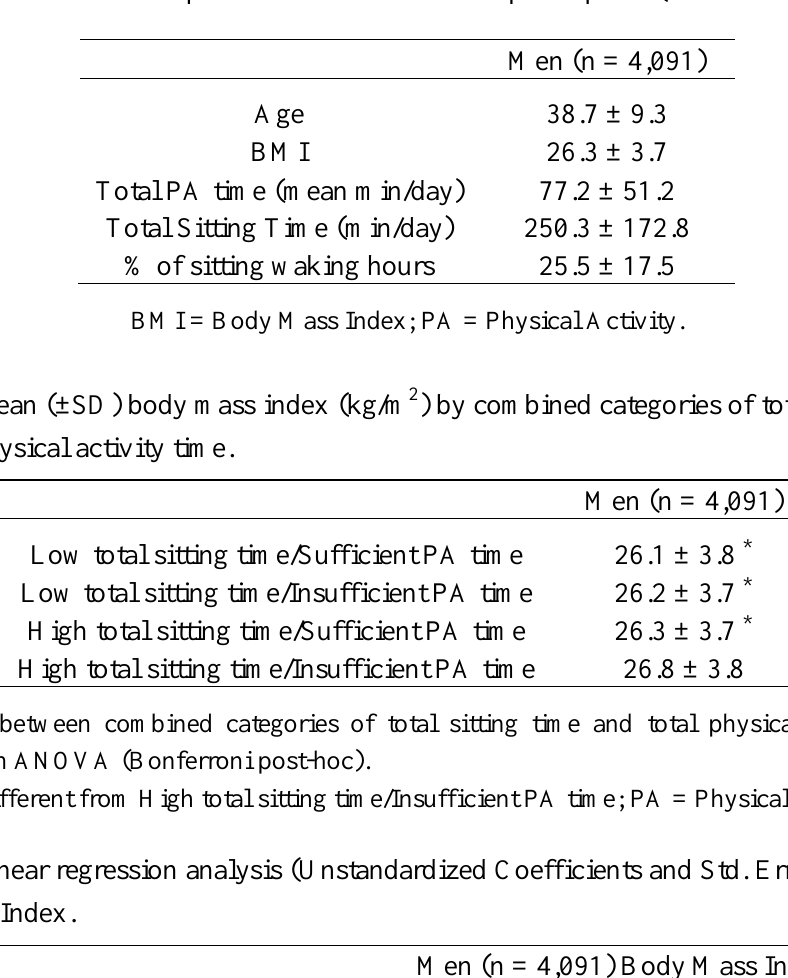
Table 1. Descriptive characteristics of the participants (mean ± SD).